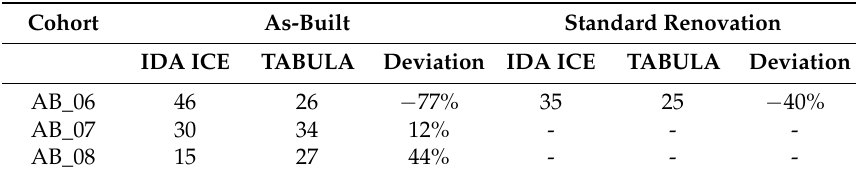
Table 6. Comparison of recovered heat from air handling unit (kWh/(m 2 · year)) for AB_06–08. AB_01–05 does not have heat